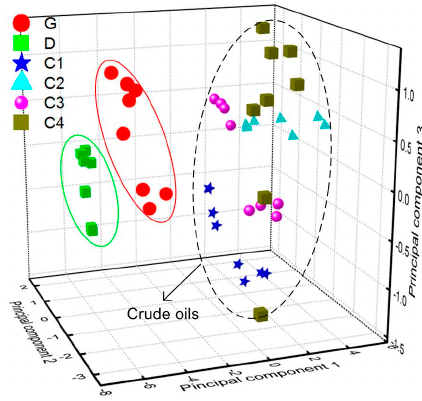
Figure 11. PCA score scatter plot of different oils on three principal components.